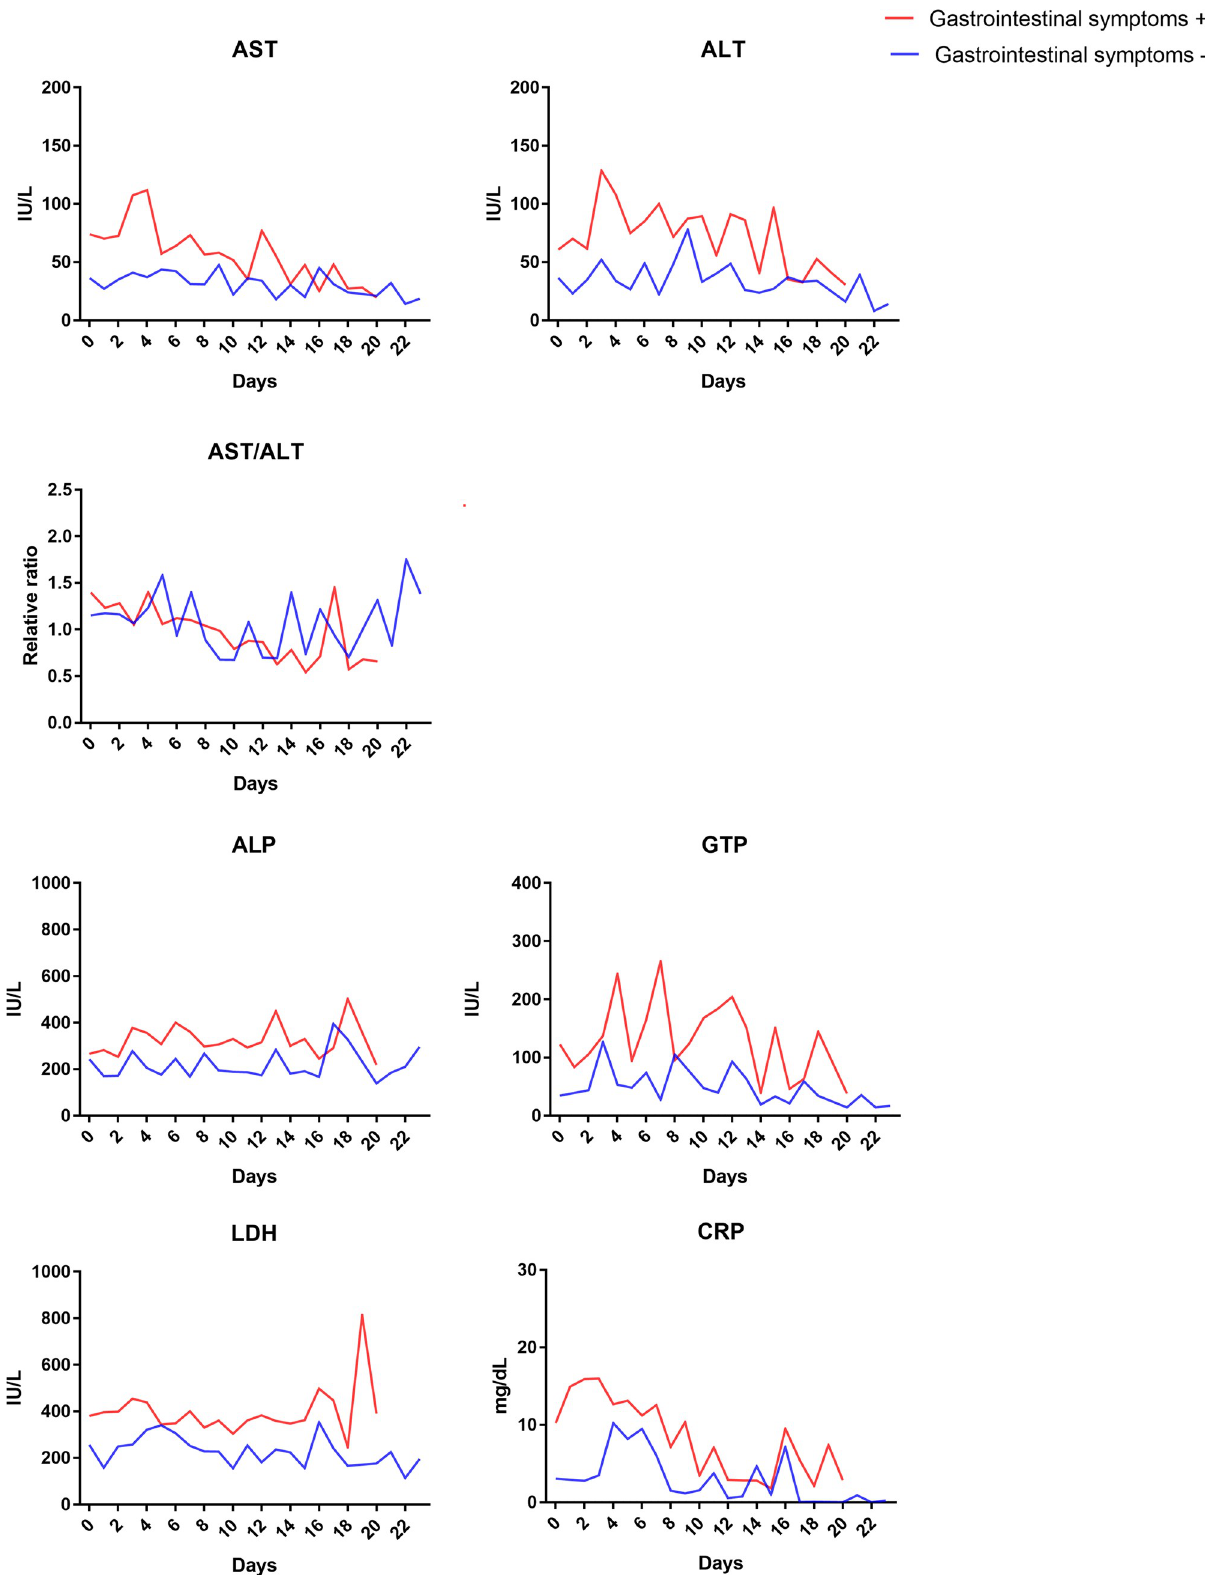
Fig 2. The dynamics of serum biochemistries of patients with COVID-19 with or without gastrointestinal symptoms. https://doi.org/10.1371/journal.pone.0241663.g002 PLOS ONE | https://doi.org/10.1371/journal.pone.0241663 November4, 2020 7 /